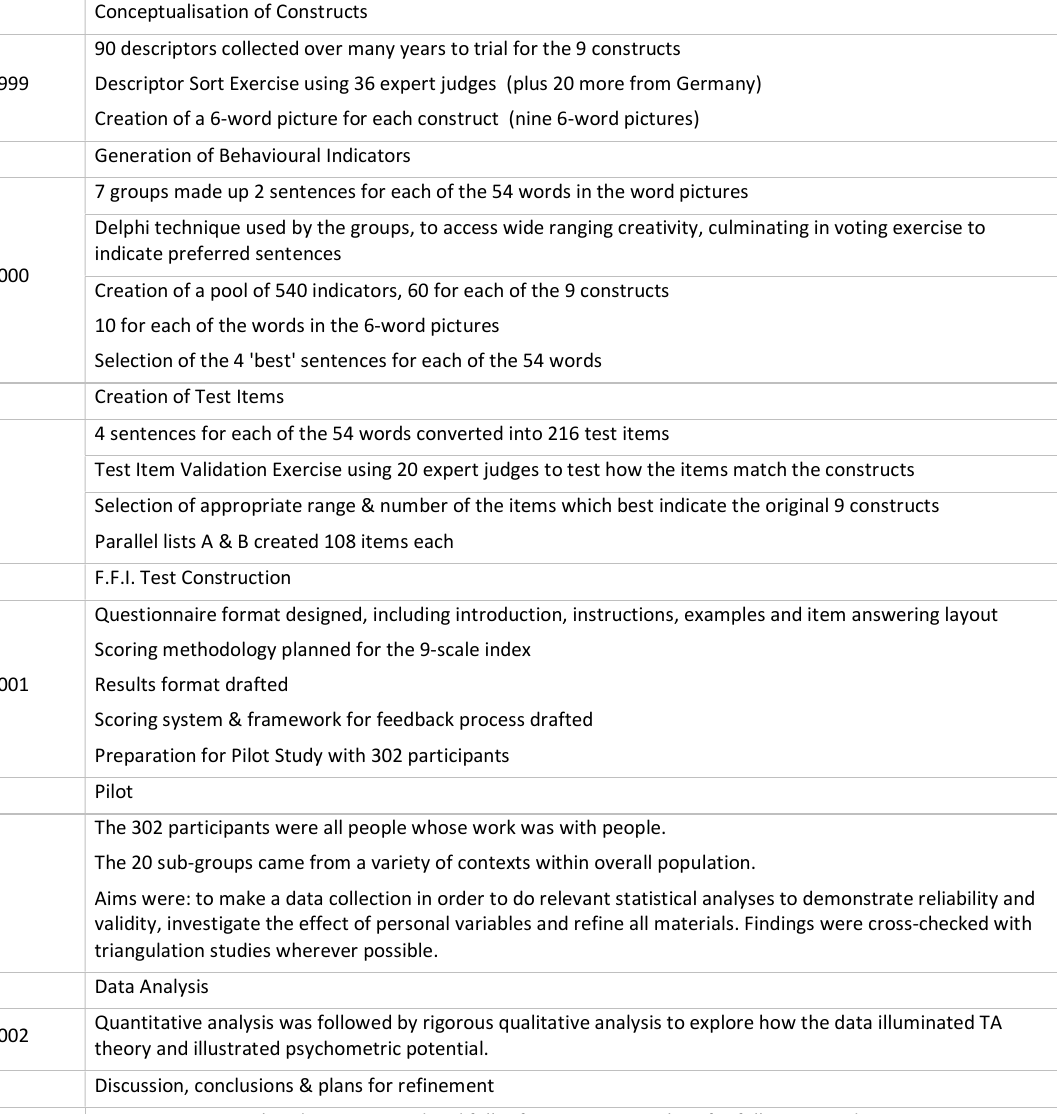
Table 1: Functional Fluency Index Project Outline 1997 -